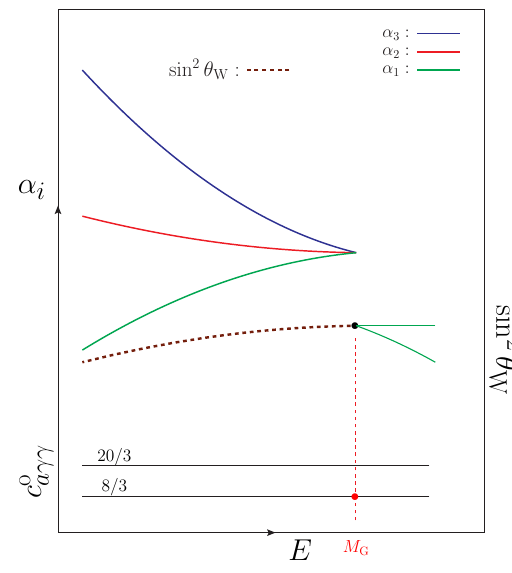
Figure 5. A schematic view on the gauge couplings, sin 2 θ W , and ˜ c a γγ